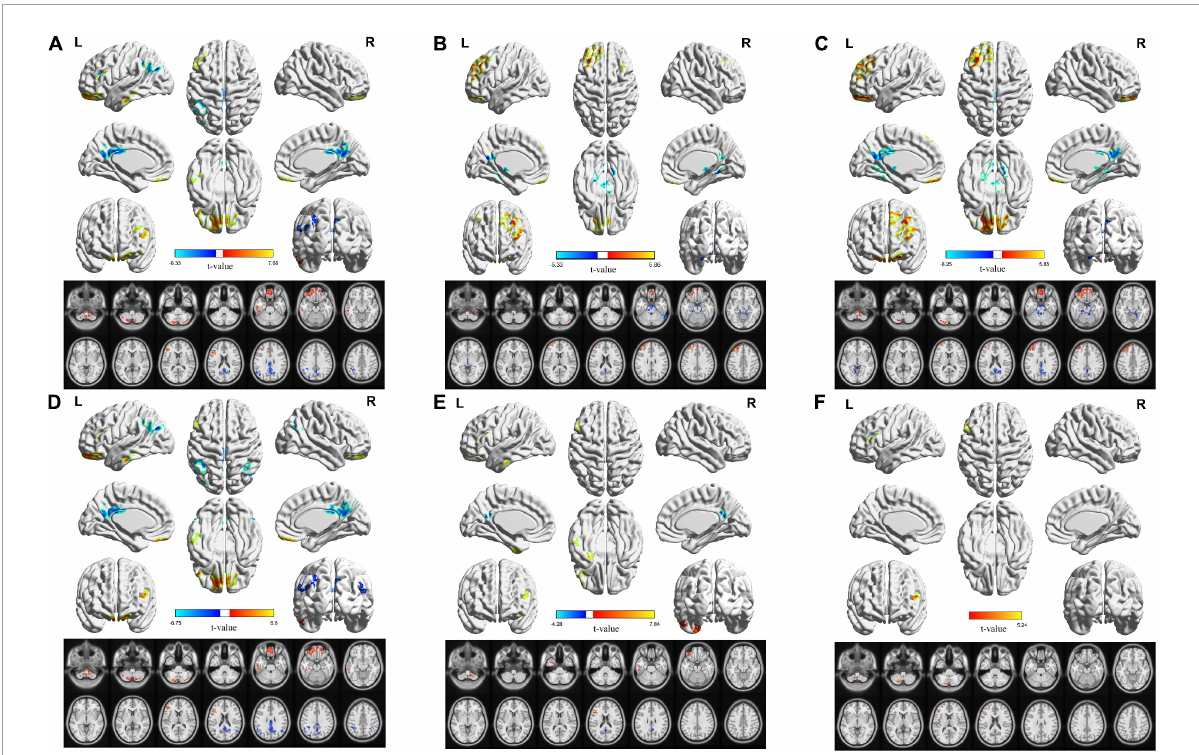
FIGURE3 Corresponding changes in ALFF values in the classical band and the slow-2 to slow-6 band in OSA patients. (A) Classical band (0.01–0.1 Hz); (B) slow-2 (0.198–0.25 Hz); (C) slow-3 (0.073–0.198 Hz); (D) slow-4 (0.027–0.073 Hz); (E) slow-5 (0.01–0.027 Hz); (F) slow-6 (0–0.01 Hz) (double tail, voxel level P < 0.01, GRF corrected, cluster level P <